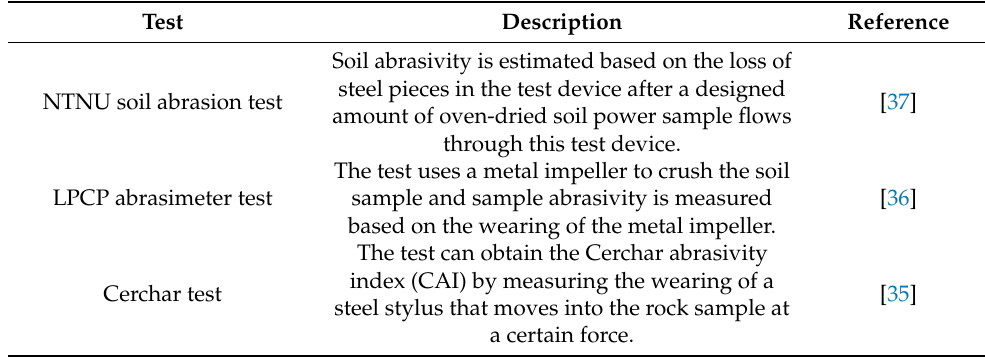
Table 1. Summary of major abrasivity test